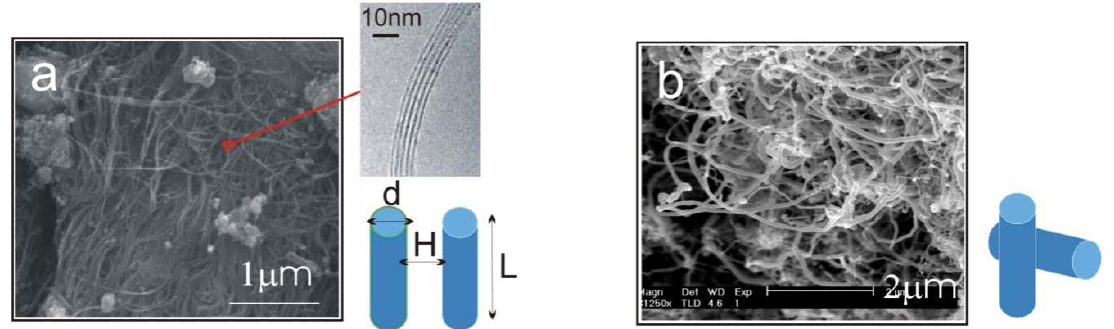
Figure 1. Scanning electron micrographs showing: ( a ) Single-wall nanotubes (SWNTs), grown by arc-discharge, with inset showing a bundle of closely-packed SWNTs; ( b ) multi-walled nanotubes (MWNTs), grown by chemical vapor deposition. The van der Waals (VdW) interaction between a pair of SWNTs or a pair of MWNTs is modeled by a pair of rods with parallel and perpendicular configuration